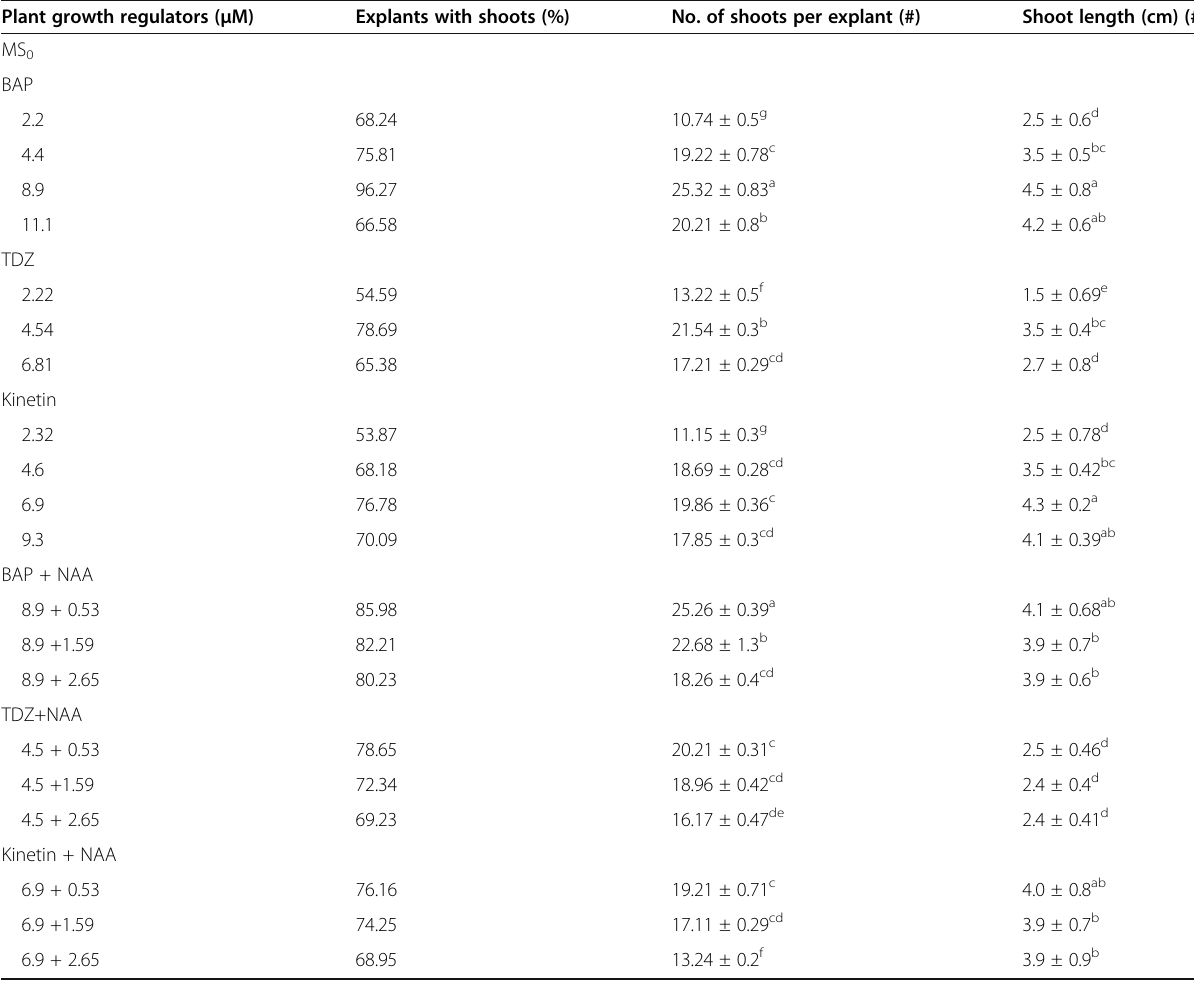
Table 1 Effect of cytokinins and NAA on shoot development from shoot tip explants of S. mollis inoculated onto MS medium after 8 weeks of culture Plant growth regulators ( μ